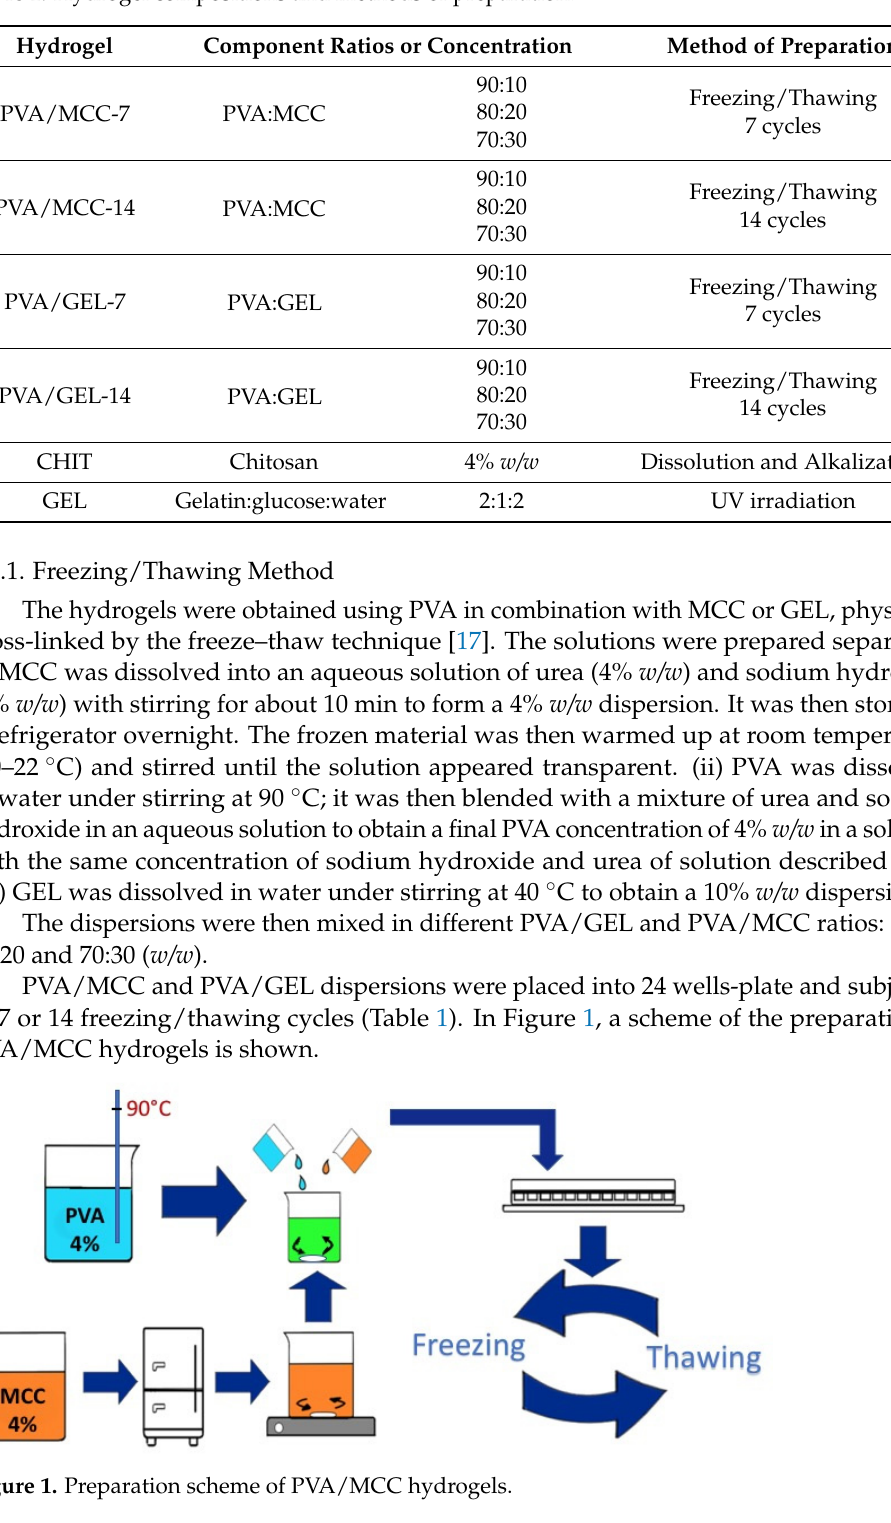
Table 1. Hydrogel compositions and methods of preparation.